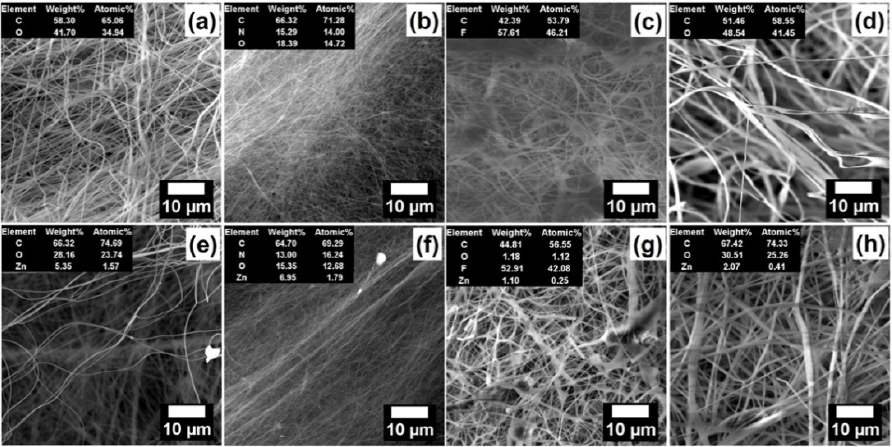
Figure 1. SEM images of the top view of PVA ( a ), PA6 ( b ), PVDF ( c ), PLLA ( d ), PVA/ZnO ( e ), PA6/ZnO ( f ), PVDF/ZnO ( g ), PLLA/ZnO ( h ) nanofibers. Inset tables are EDX measurements for each sample.